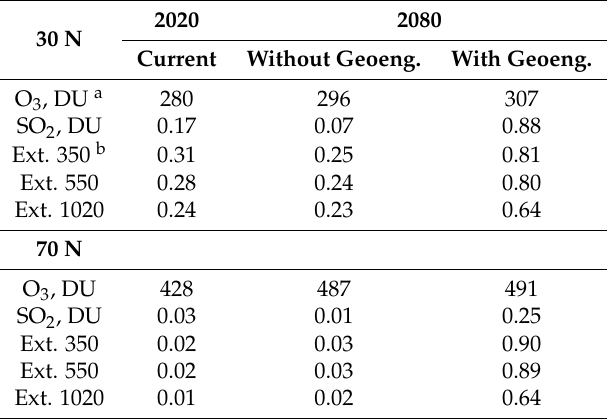
Figure 1. The zonal averaged stratospheric sulfate aerosol distribution for the geoengineering experiment in March 2080. The black curve shows approximate tropopause location. The column optical properties for current and future conditions (March) from the CESM1(WACCM)